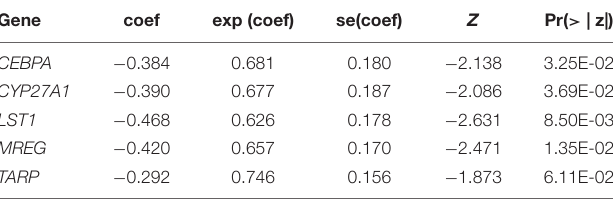
TABLE 1 | The statistics for the gene signatures in the multivariable Cox